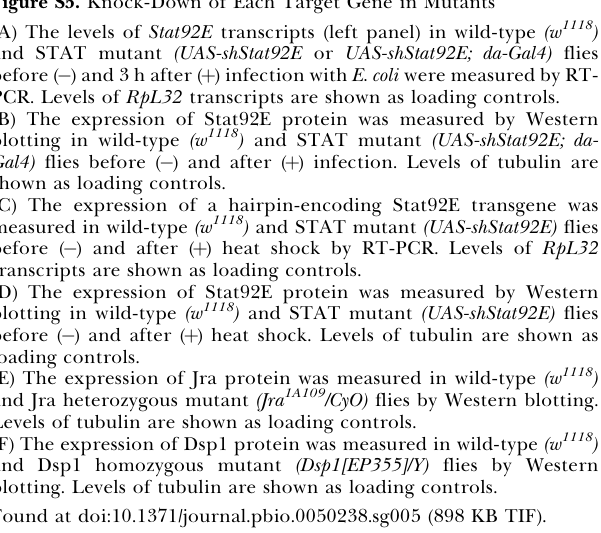
Figure S1. Down-Regulation of Attacin-A Transcripts by Hopscotch and Stat92E Levels of Attacin-A transcripts in SL2 cells treated with dsRNA for Luciferase (solid diamonds), Hopscotch (solid squares), Stat92E (open triangles), and Relish (open circles) are shown along with the time after LPS/PGN (10 l g/ml) treatment. The degree of depletion of the corresponding transcript by RNAi is shown in the bottom panel. Figure S2. Alignment of the Attacin-A Promoter Regions of Drosophila Species (A) The upstream regions of Attacin-A genes of different Drosophila species have evolutionarily conserved transcription factor binding motifs. The alignment was performed using vector NTI (Informax). The absolute complexity of the y- axis was calculated as the sum of all pairwise residue substitution scores at a given alignment position normalized by the number of pairs in the alignment. A higher y value indicates higher sequence conservation. The x- axis indicates the distance from the start site on the Attacin-A promoter. The transcription factors are listed at the top. (B) The promoter sequences of the Attacin-A genes of five Drosophila species that have diverged for at most 60 My were aligned with vector NTI (Informax) and visualized with the Box Shade 3.21 program at http://www.ch.embnet.org. The evolutionarily conserved sequence motifs are marked at the top. Sequences completely conserved are shown in black and sequences more than 80% conserved are shown in gray. The relative distances of the sequences from the transcription initiation site are indicated. Figure S3. Supershift Assay